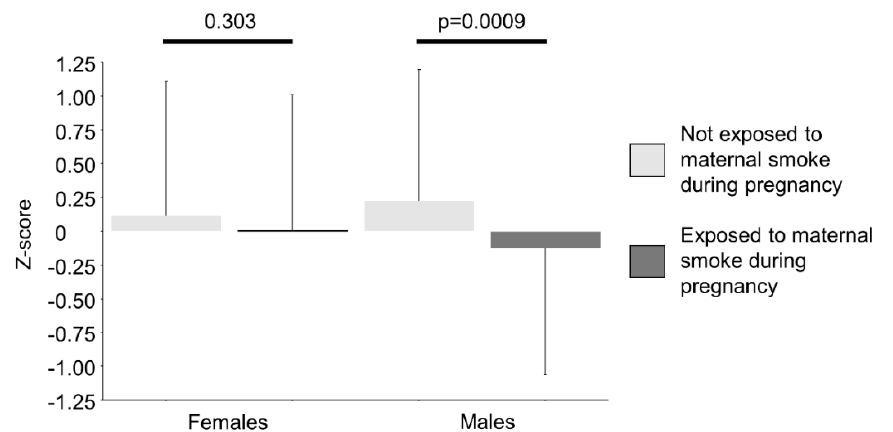
Figure 1. Means (± SD) of FEF 25–75% (z-score) separately by sex and exposure to maternal smoke during pregnancy. Differences were evaluated by means of one-way ANOVA and Fisher’s LSD. Table 7. Multiple linear regression model for FEF 25–75% (as z-score) in the overall study population ( n = 1714). Four combinations of exposure to maternal smoke during pregnancy and sex were separately evaluated. Significant p -Values are in bold.